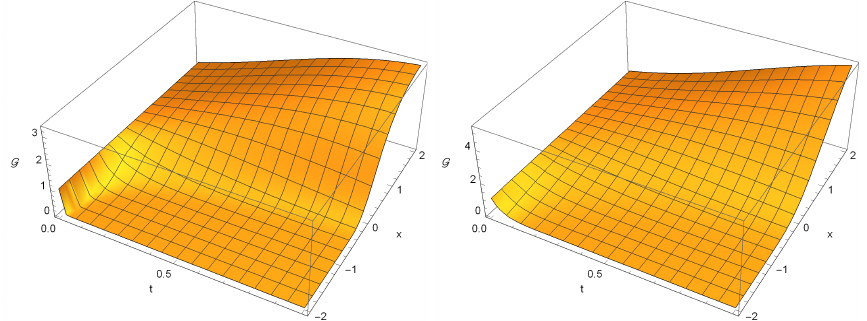
Figure 1. The surface for the solution G ( t , [ x ] q )